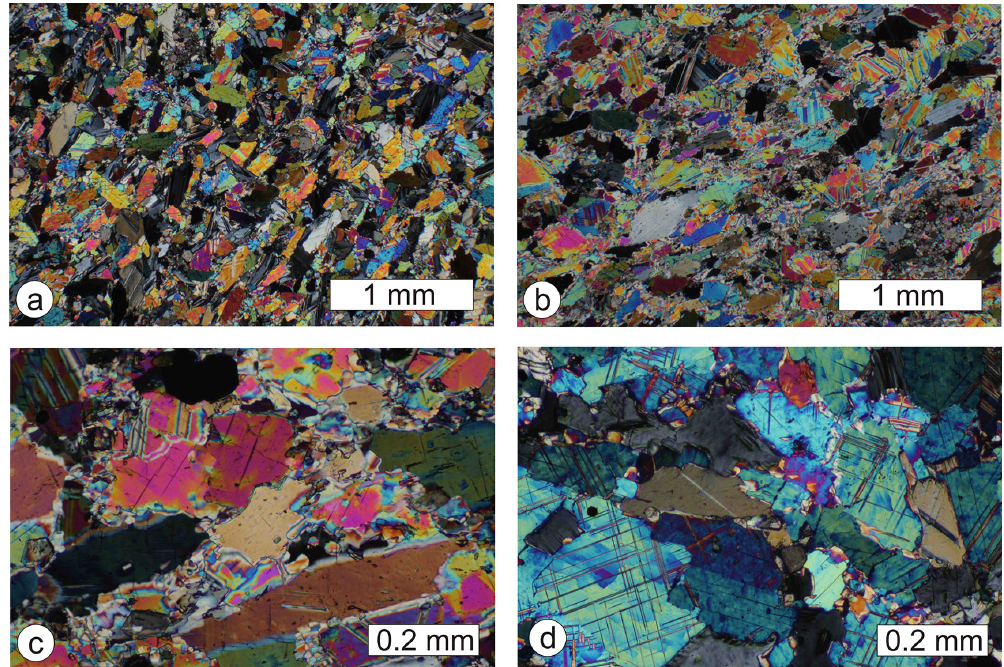
Figure 2. Microstructure of anhydrite rock from Gipswerk Moosegg (sample #14247, Mineralogical Collection, Ruhr University Bochum) used as starting material (optical micrographs with crossed polarizers; thin section normal to stretching lineation); (a) and (b) examples revealing heterogeneity of material on mm-scale, with elongated grains parallel to foliation and variable grain size; (c) elongated large grains define foliation with irregular and sutured high-angle grain boundaries, surrounded by small recrystallized grains; (d) two sets of thin lamellar twins, discernible in many grains, reflect the preferred orientation of [001] (cf. Fig. 1) normal to the thin section and parallel to the lineation of the starting